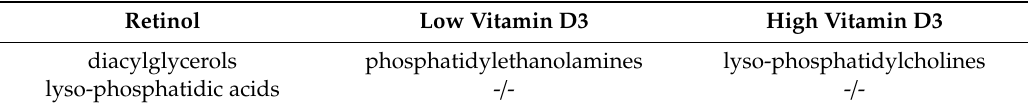
Table 2. Significantly increased cell membrane constituents upon treatment of HaCaT cells with Al 0 NMs divided by the additional treatment of either retinol low or high vitamin D3.